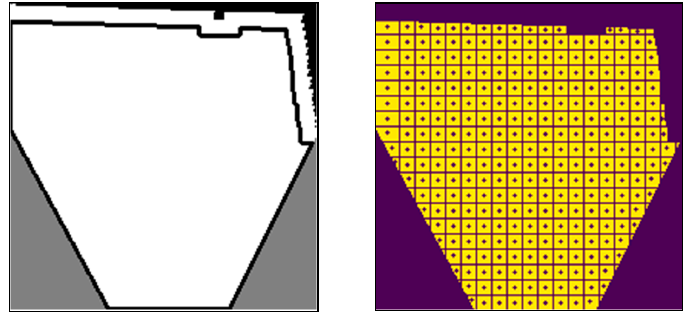
Figure 9. The mobile robot’s bird view.